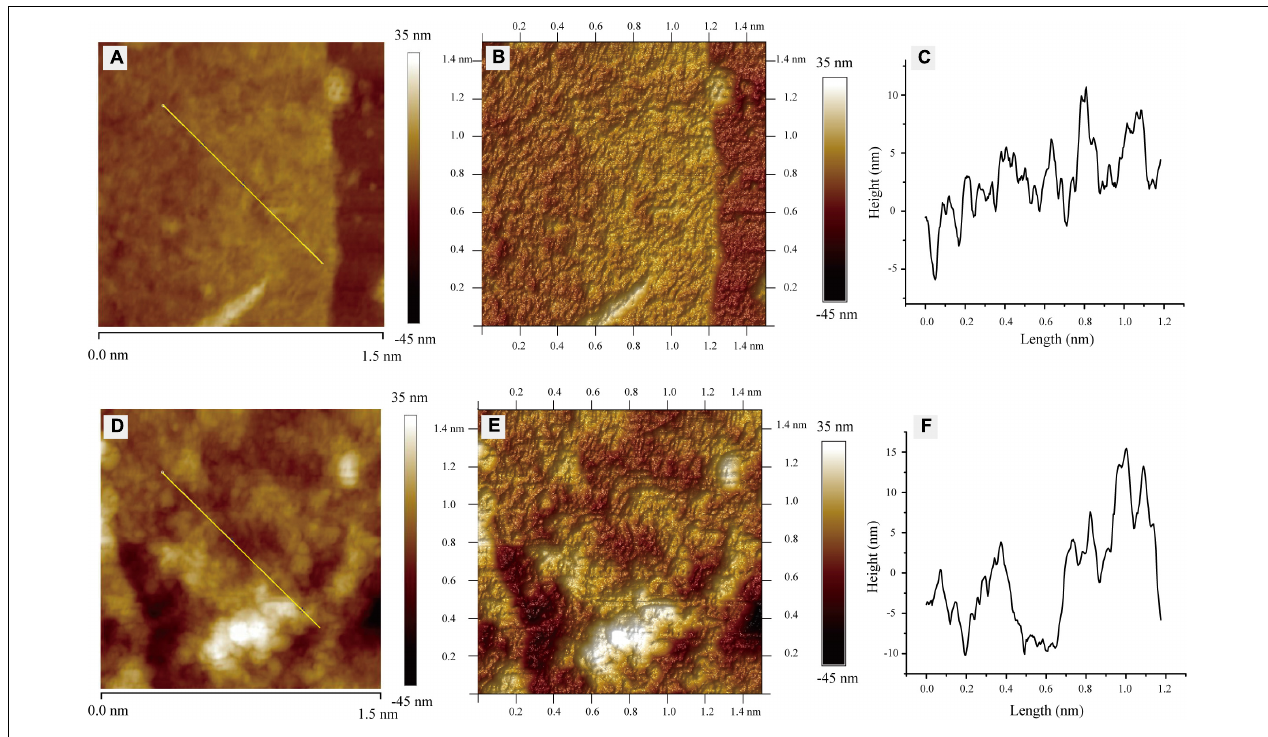
FIGURE 6 | Atomic force microscopy images of G. lucidum . (A) Two-dimensional image of G. lucidum . Straight line is for the line profile analysis. (B) Three-dimensional rendering of panel (A) . (C) A height profile of over 1.2 µ m for straight line in panel (A) . (D) Two-dimensional image of the L-phenylalanine-treated group. A straight line is for line profile analysis. (E) Three-dimensional rendering of panel (D) . (F) The height profile over 1.2 µ m for a straight line in panel (D)